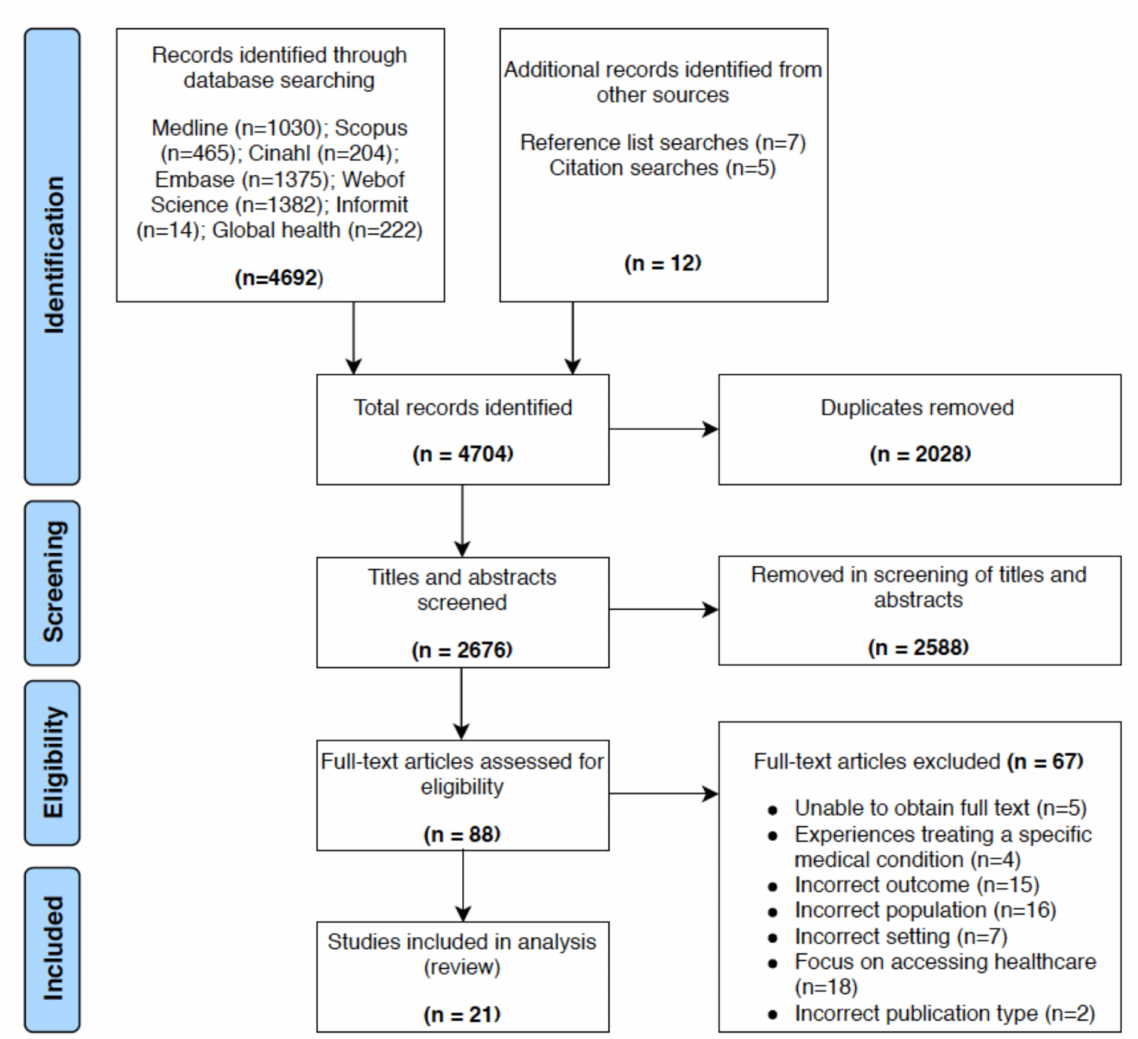
Figure 1. PRISMA flow diagram: The PRISMA diagram details the search strategy and selection